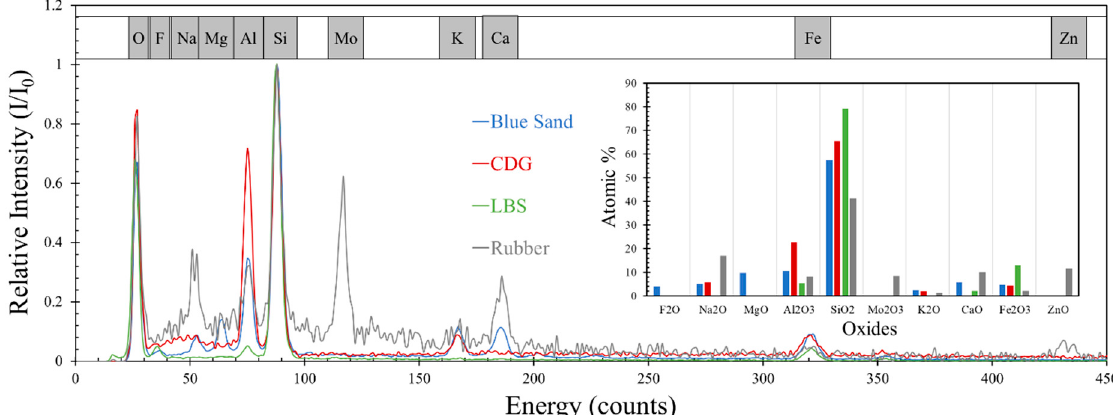
Figure 2. Element spectra of four materials tested and atomic percentages of corresponding oxides in each material.